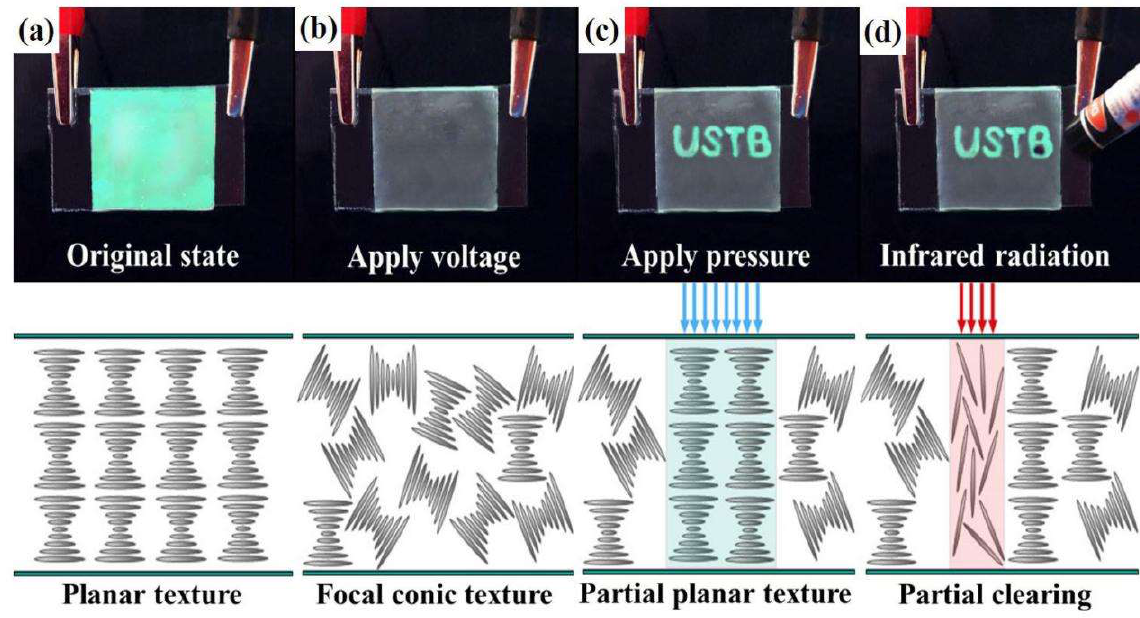
Figure 5. Four main stages of the LC cell: ( a ) reflective state with planar texture. ( b ) Applied voltage to reflective LC cell, the mixture would change into the focal conic texture. ( c ) When applying pressure to non-reflective samples, the stressed part would return to planar texture. ( d ) When irradiating the NIR light source at the pattern, the partial LC cell would be heated rapidly to the clearing point. The molecular arrangement of every stage was directly below the specific image of the